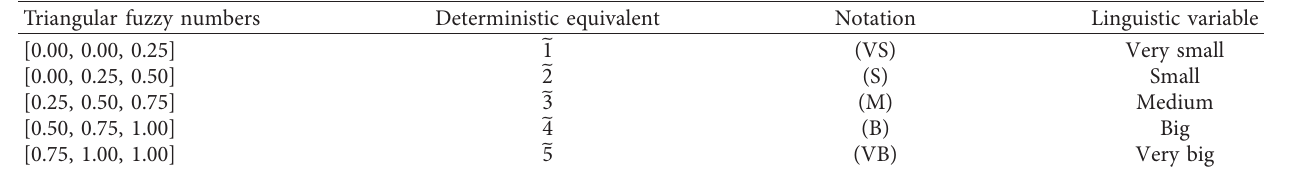
Figure 4: (a). Fuzzy number and its corresponding Z-number in the α < 1 condition. (b). Fuzzy number and its corresponding Z-number in the α � 1 condition. Table 2: Linguistic variables used and their corresponding fuzzy